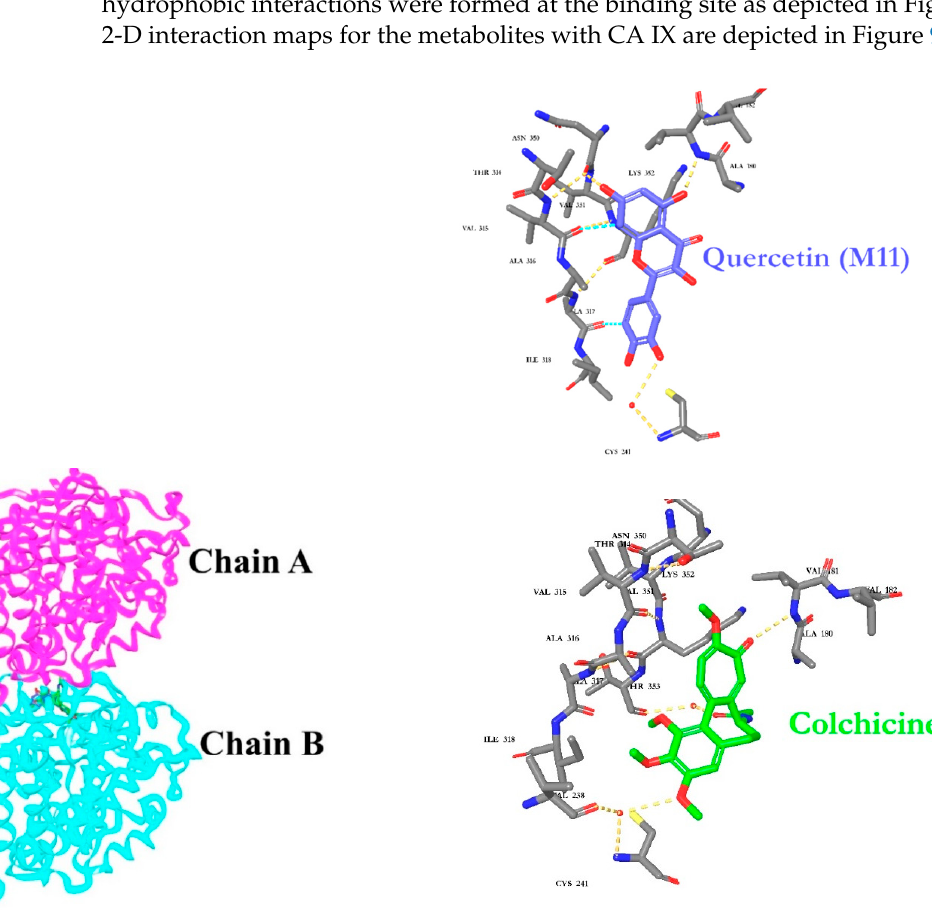
Table 4. Docking scores of identified metabolites with Tubulin crystal structure.